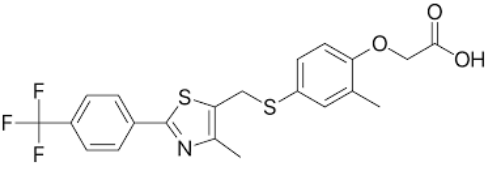
muscle mass and strength.